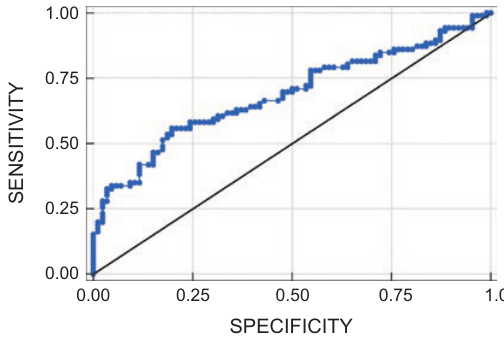
Figure 1: Receiver operator curve of white cell count